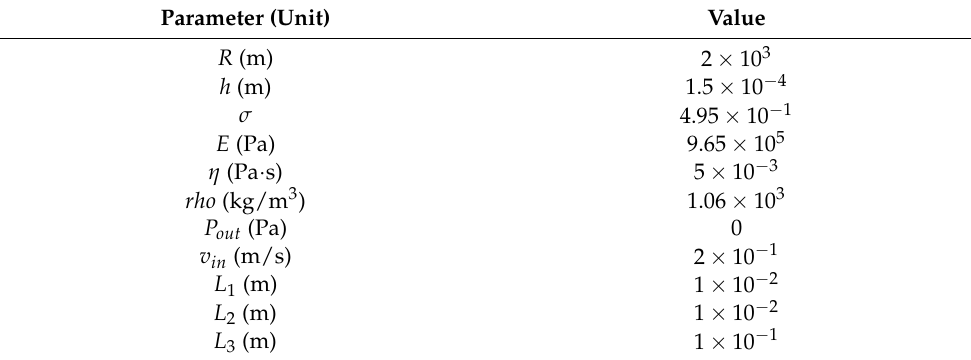
Table 1. Hemodynamic model simulation parameters [26,27]. Parameter (Unit)